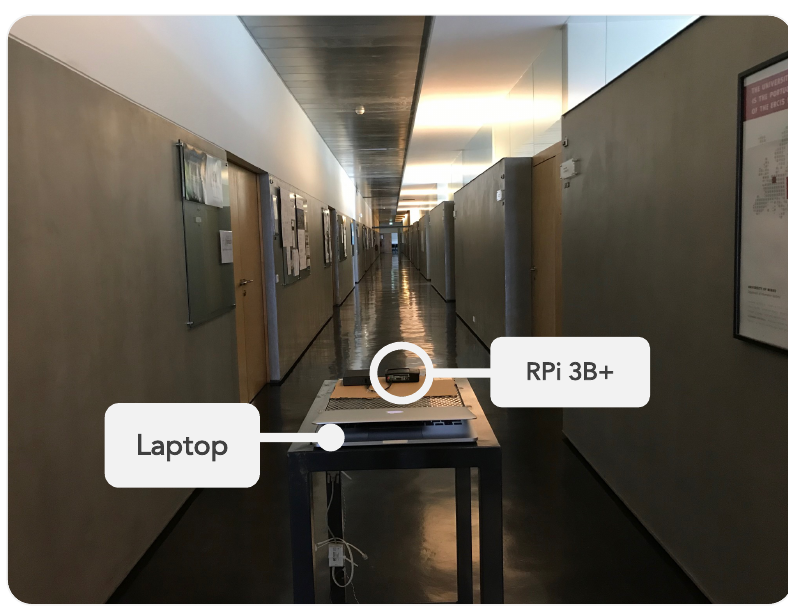
Figure 3. Experimental